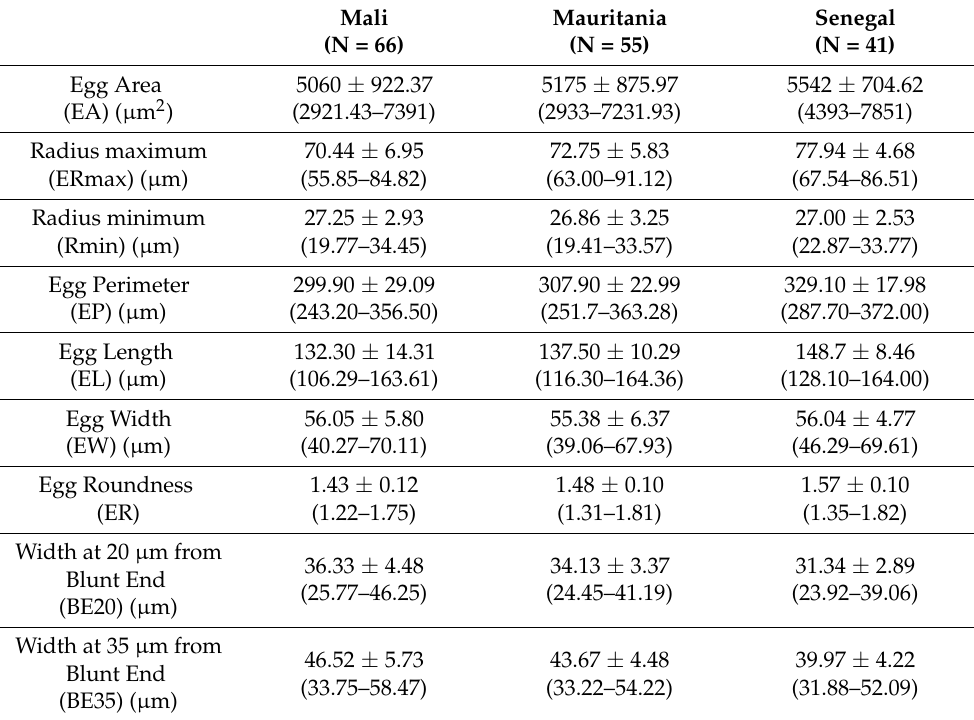
Table 3. Measurements of S. haematobium eggs grouped by country of origin. Mean ± SD (Min–Max).